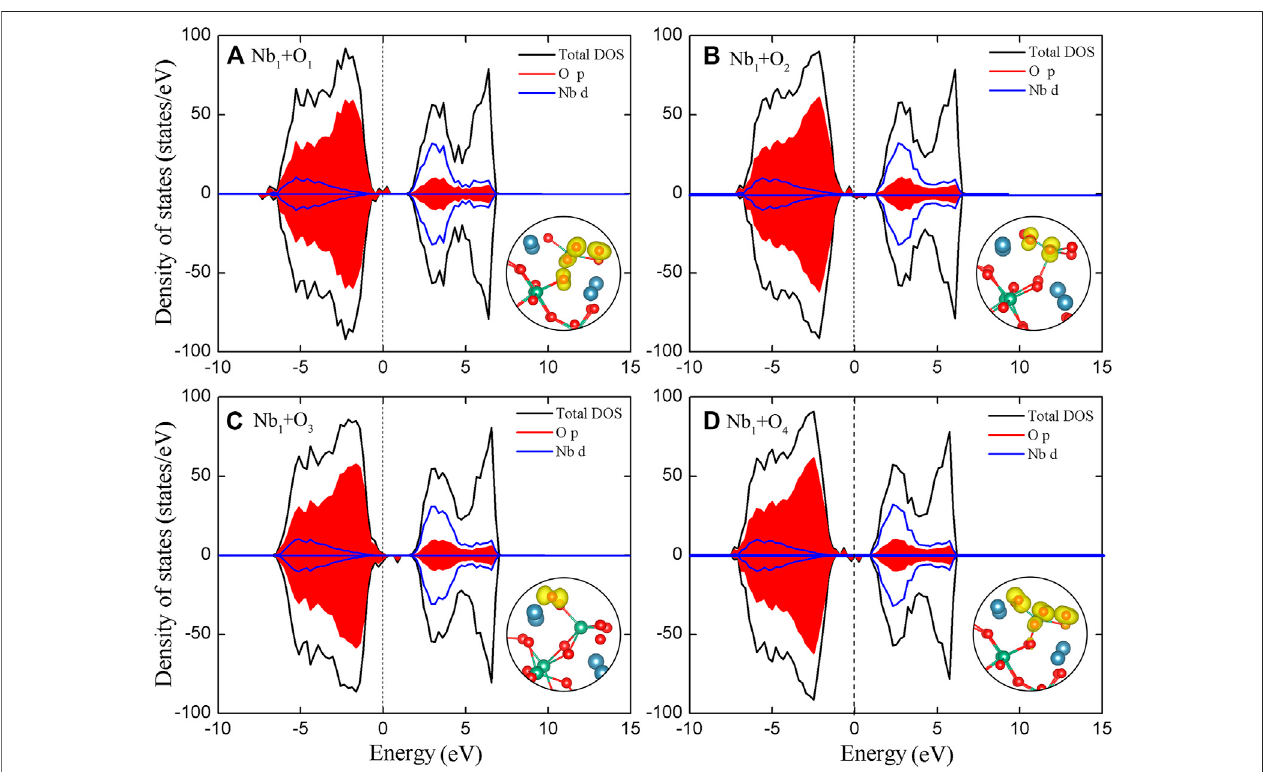
FIGURE 6 | Total and partial DOSs of Ca 2 Nb 2 O 7 (010) surface with the complex vacancy of VNb+O in the distributions of Nb 1 +O 1 (A) , Nb 1 +O 2 (B) , Nb 1 +O 3 (C) , and Nb 1 +O 4 (D) . The insets show the corresponding three-dimensional iso-surfaces of magnetization density.